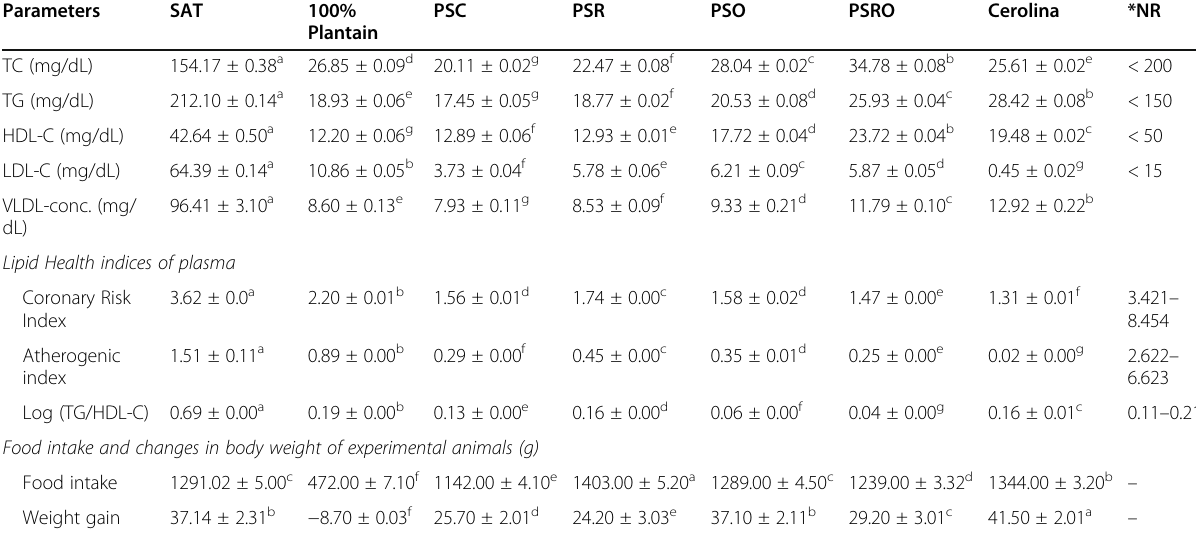
Key: SAT: rats fed with basal diet + Satin; PLT: rats fed with %100 Plantain; PSC rats fed with (Plantain 70%+Soycake 30%); PSR: rats fed with (Plantain 65%+ Soycake 30%+Rice bran 5%); PSO: rats fed with (Plantain 65%+Soycake 30%+Oat bran 5%); PSRO: rats fed wit (Plantain 60%+Soycake 30%+Oat bran 5%+ Rice bran 5%) and Cerolina. *NR: American Diabetes Association